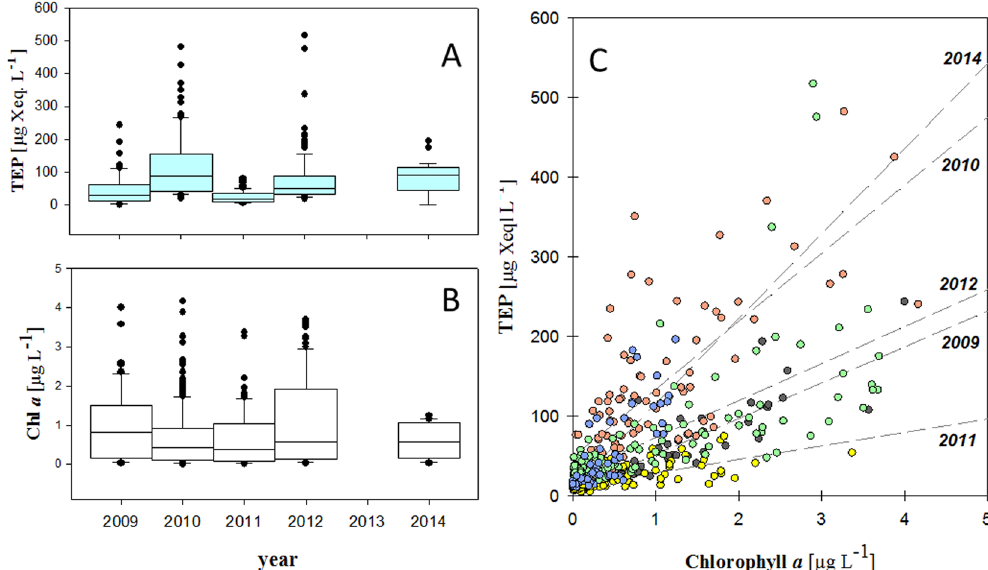
Figure 2. (a–c) Variability of transparent exopolymer particles (TEP, A ) and Chlorophyll a (Chl a , B ) concentrations at the HAUSGARTEN Arctic monitoring site during summer (2009–2014). TEP and Chl a concentrations were significantly correlated in each year ( p < 0.001), but the increase in TEP relative to Chl a concentration varied strongly between years ( C ). Color code ( C ): yellow 2011, grey 2009, green 2012, red 2010, blue